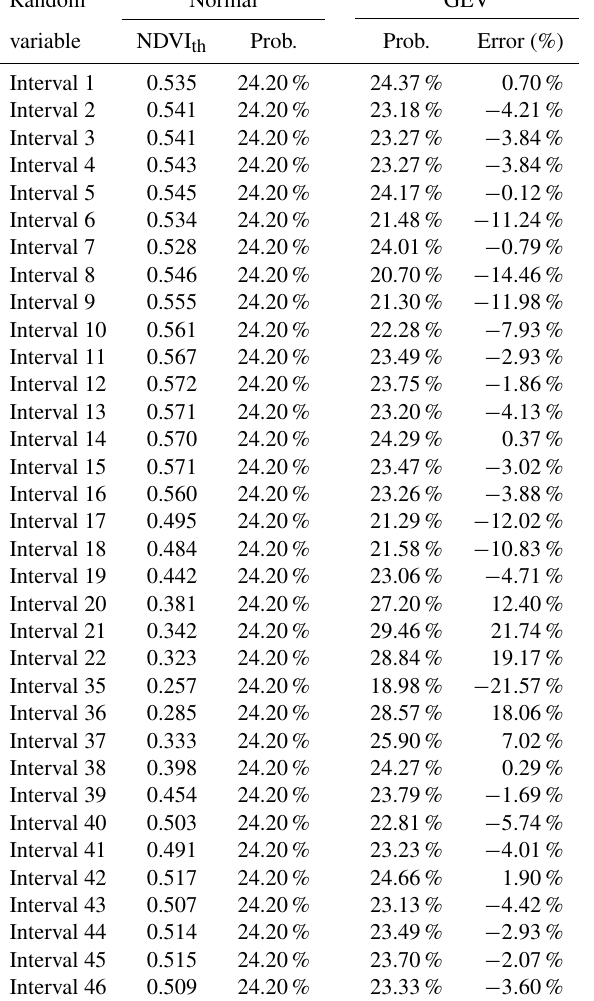
Table 4. First column: time intervals of approximately 8d through- out the year. Second column: NDVI thresholds (NDVI th ) based on a normal distribution applying µ − 0 . 7 × σ . Third column: percent- ages of area below the NDVI th when normal distributions are ap- plied. Fourth column: percentages of area below the NDVI th when GEV distributions are applied. Fifth column: relative area error of GEV compared to the normal distribution.